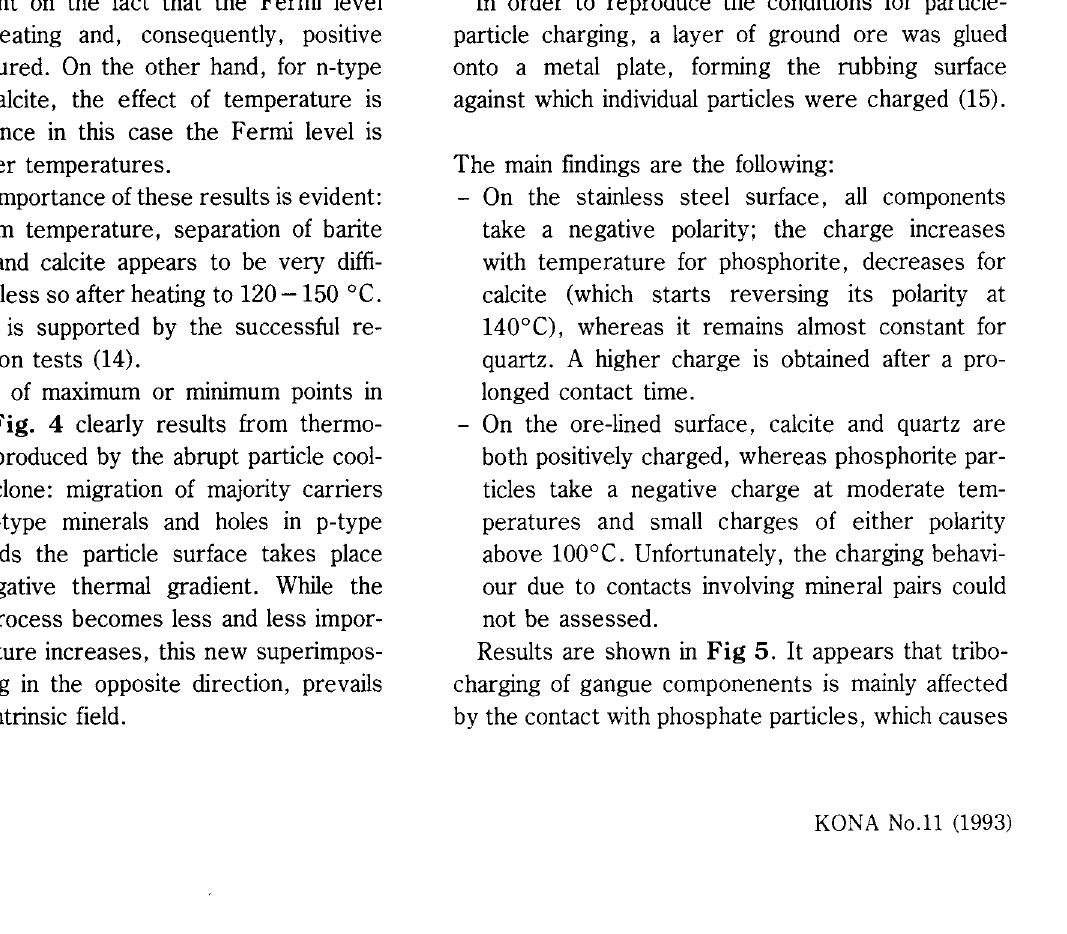
Mass fraction deflected towards the negative electrode of the tribocyclone separator as a function of feed heat ing temperature. (1) Fluorspar; (2) Barite; (3) Calcite; (4)